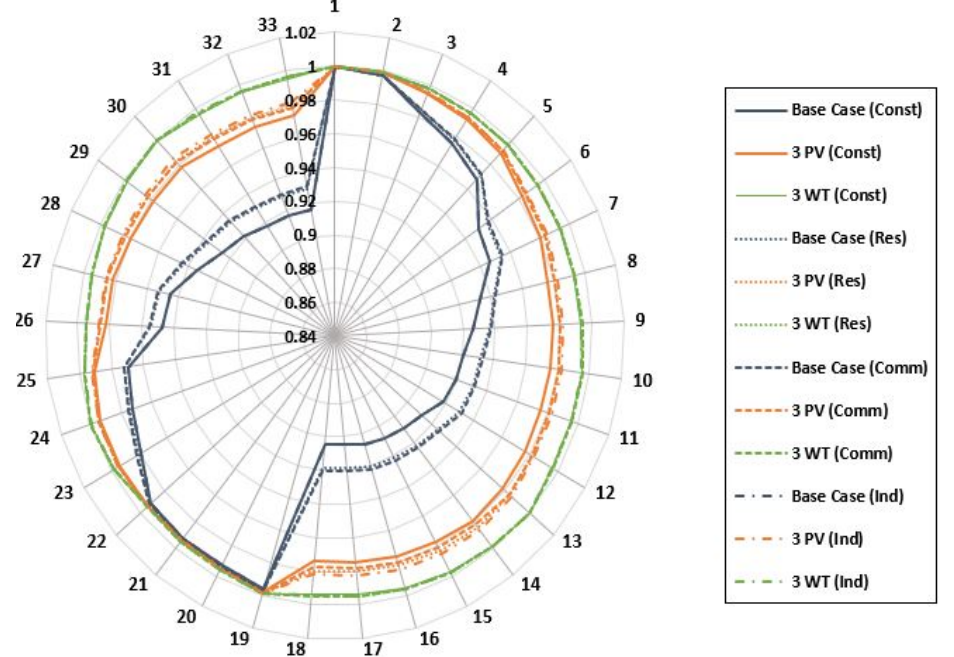
Figure 4. Voltage profiles for an IEEE 33-bus system for different loads in different cases for scenario 1.